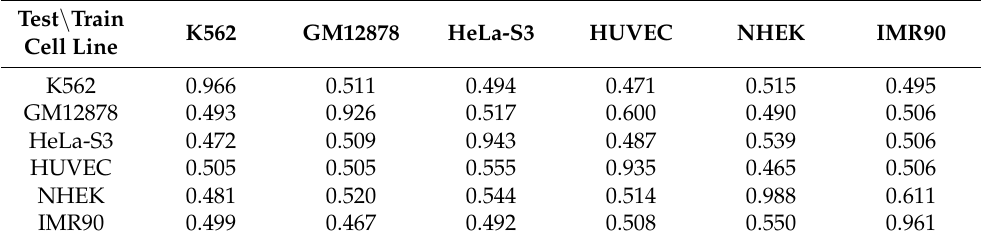
Table 3. AUPR (area under the precision–recall curve) value of cell line-specific model in different cell lines.